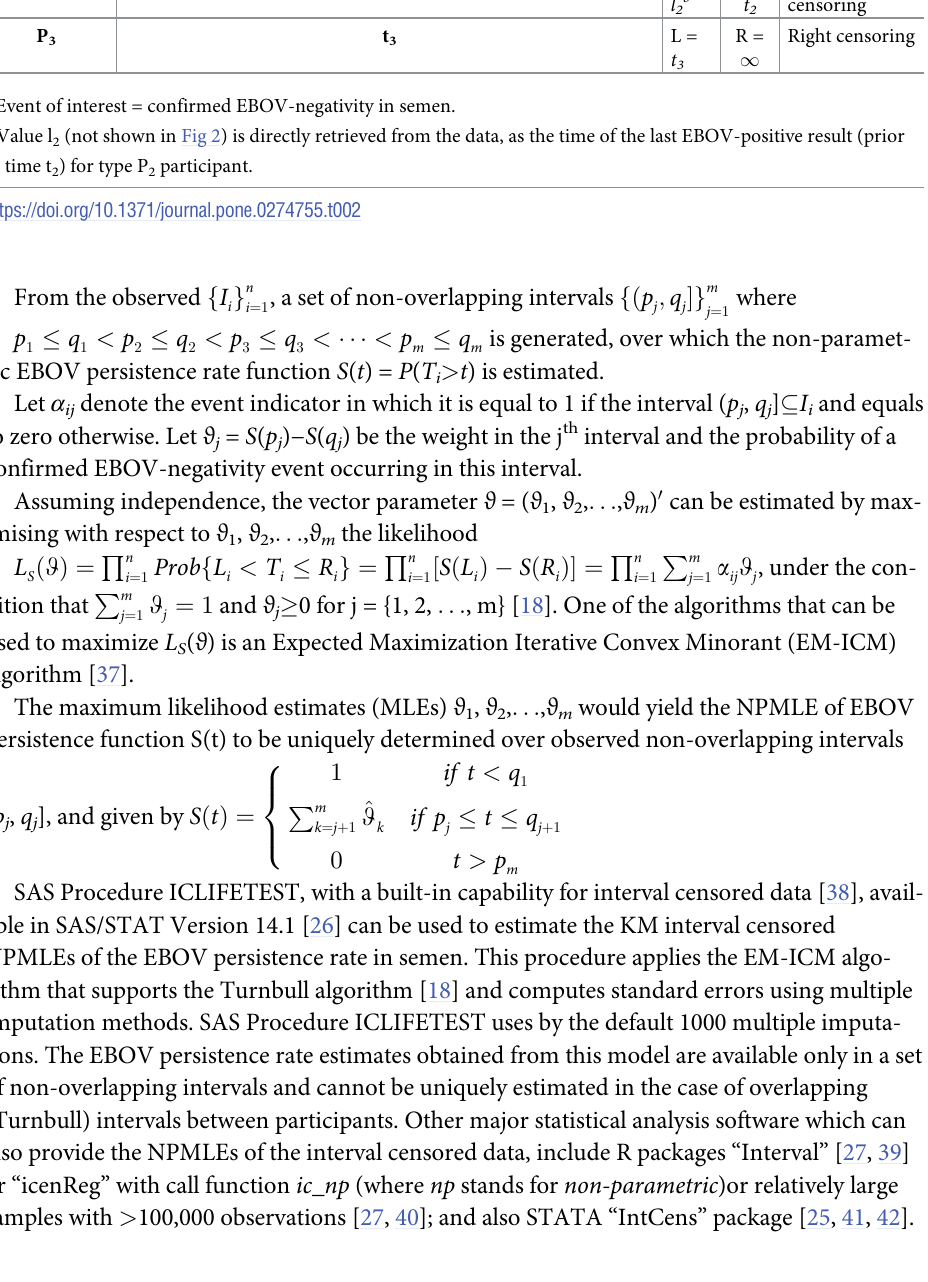
a Event of interest = confirmed EBOV-negativity in semen. b Value l 2 (not shown in Fig 2) is directly retrieved from the data, as the time of the last EBOV-positive result (prior to time t 2 ) for type P 2